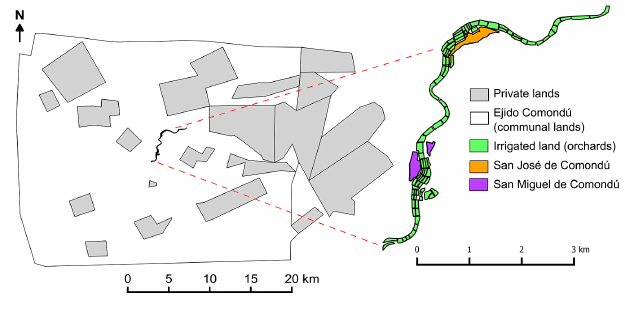
Fig. 2 . The study area with details of the irrigated land and local